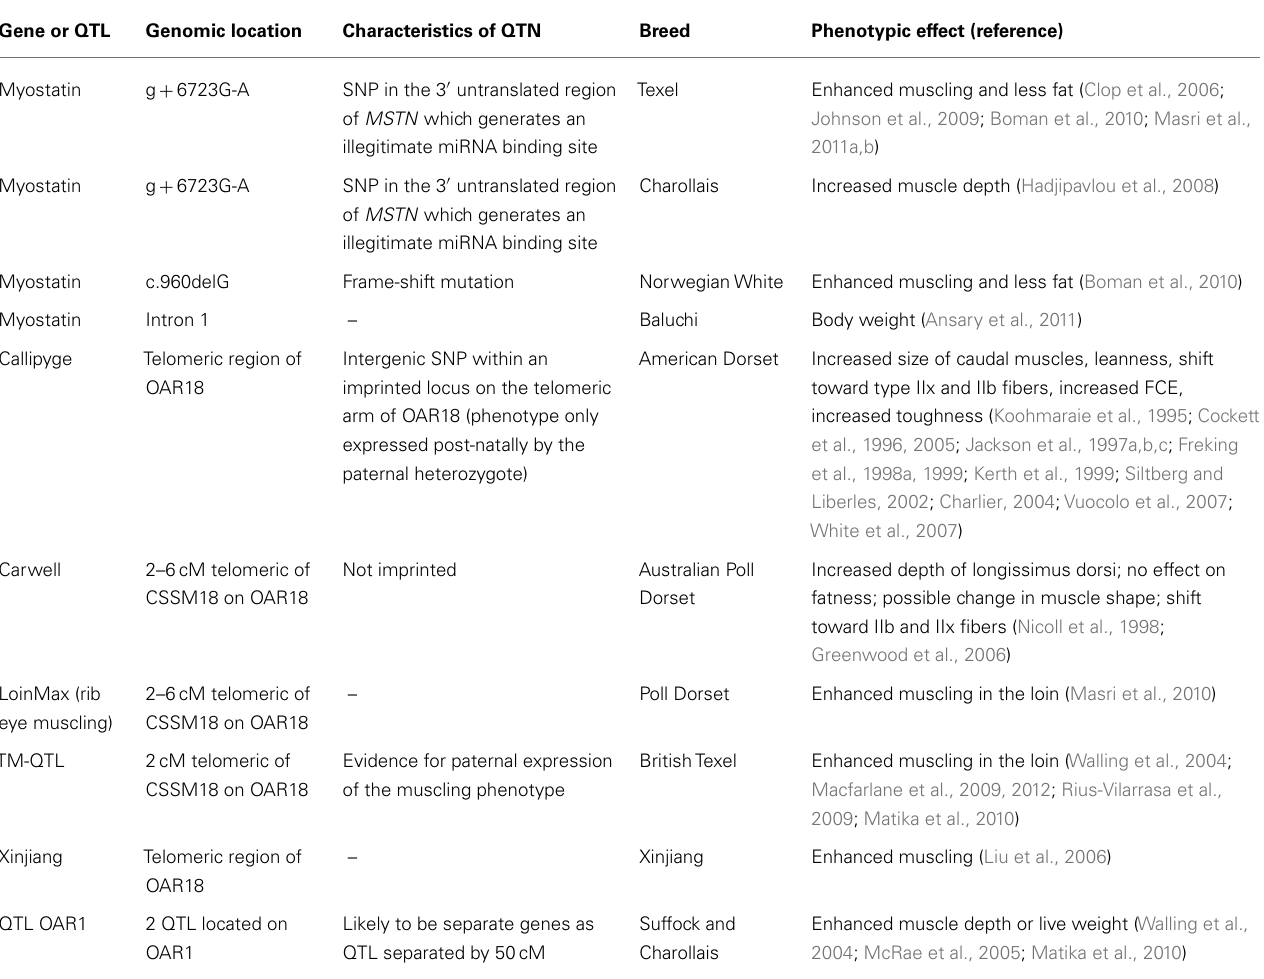
Table 1 | Characteristics of genes affecting muscling in